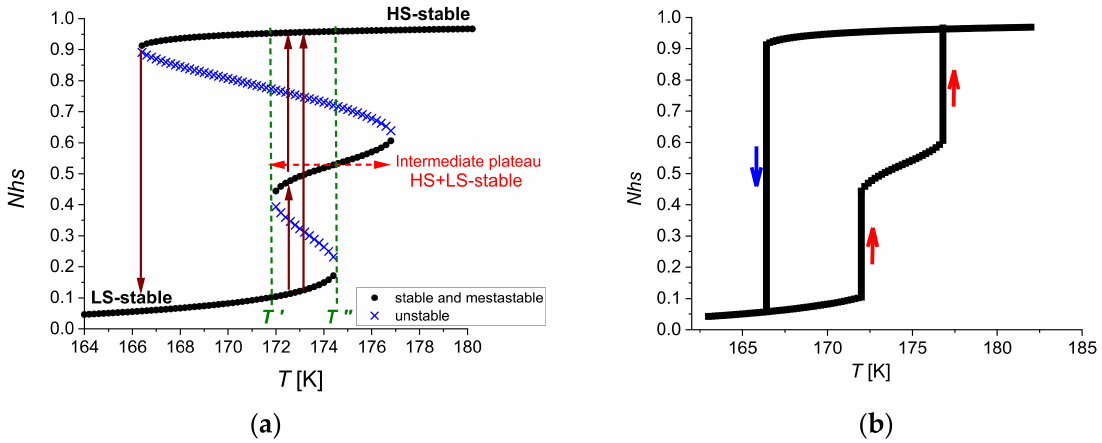
Figure 7. Thermal evolution of the HS molar fraction in a square SCO lattice with size 6 × 6. The computational parameters are L / k B = 240 K, G / k B = 172 K, J bb / k B = 60 K, J ss / k B = 60 K, J bs / k B = 50 K and ln( g ) = 6.01. ( a ) All the solutions are shown. The curve indicates the three states between T (cid:48) and T (cid:48)(cid:48) . ( b ) A two-step transition on the heating mode and one-step on the cooling mode is